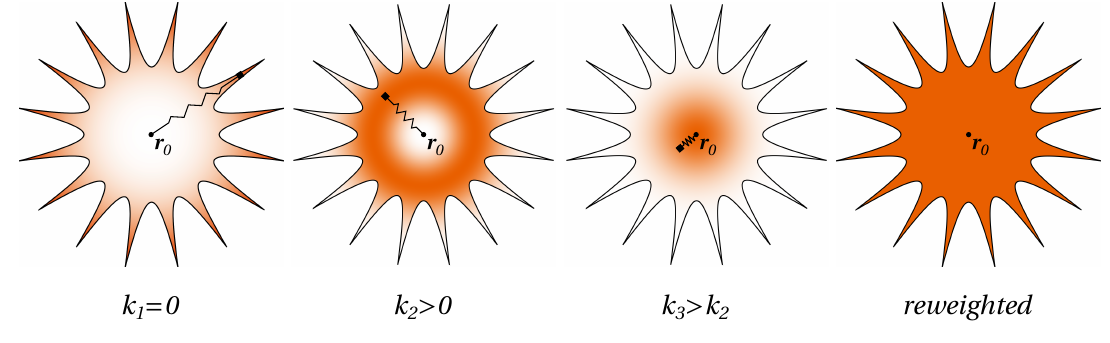
Figure 4: Probing basin volumes with random walks. Different random walkers are linked by springs with different rigidities to the configuration at the minimum. The first three panels represent the probability density of the trajectories of such walkers, with rigidities growing from left to right. At very small (possibly negative) rigidities, the walker explores the outer rim of the basins, following tentacle-like structures, while at large rigidities the random walk typically explores a hypersphere around the minimum. Putting together and properly reweighing the information sampled by these walkers, one can faithfully recover the full volume as if it had been uniformly sampled (last